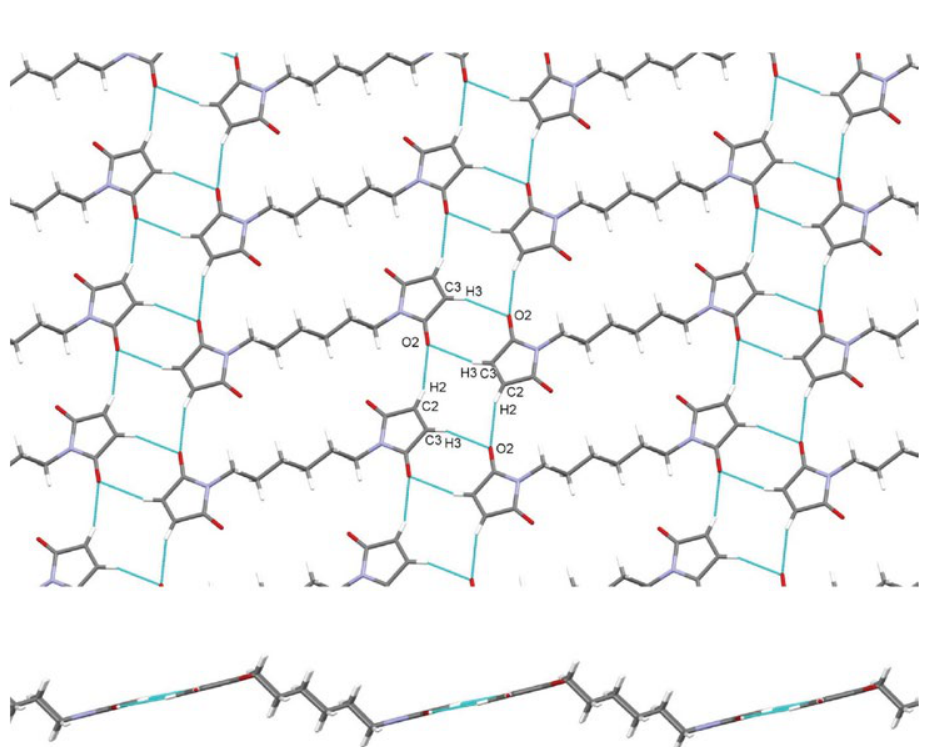
(8) and R 2 (10) (top). View 2 4